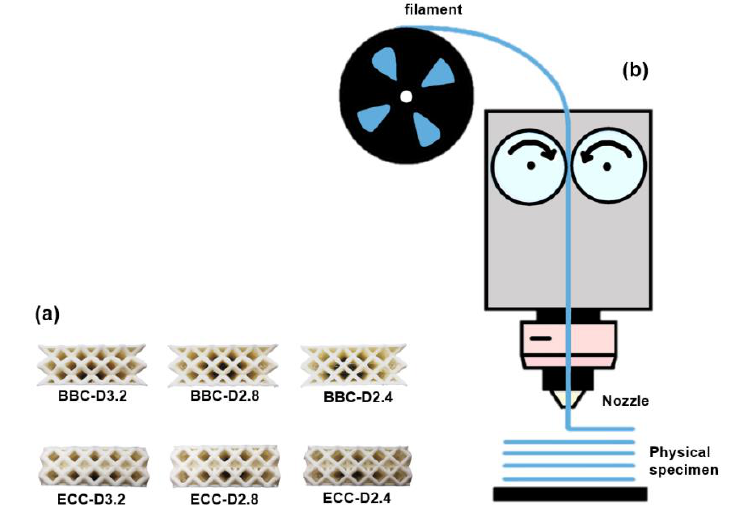
Figure 6. ( a ) The TPU 95A specimens of sandwich structures with six types of lattice core fabricated by ( b ) FDM manufacturing technique.